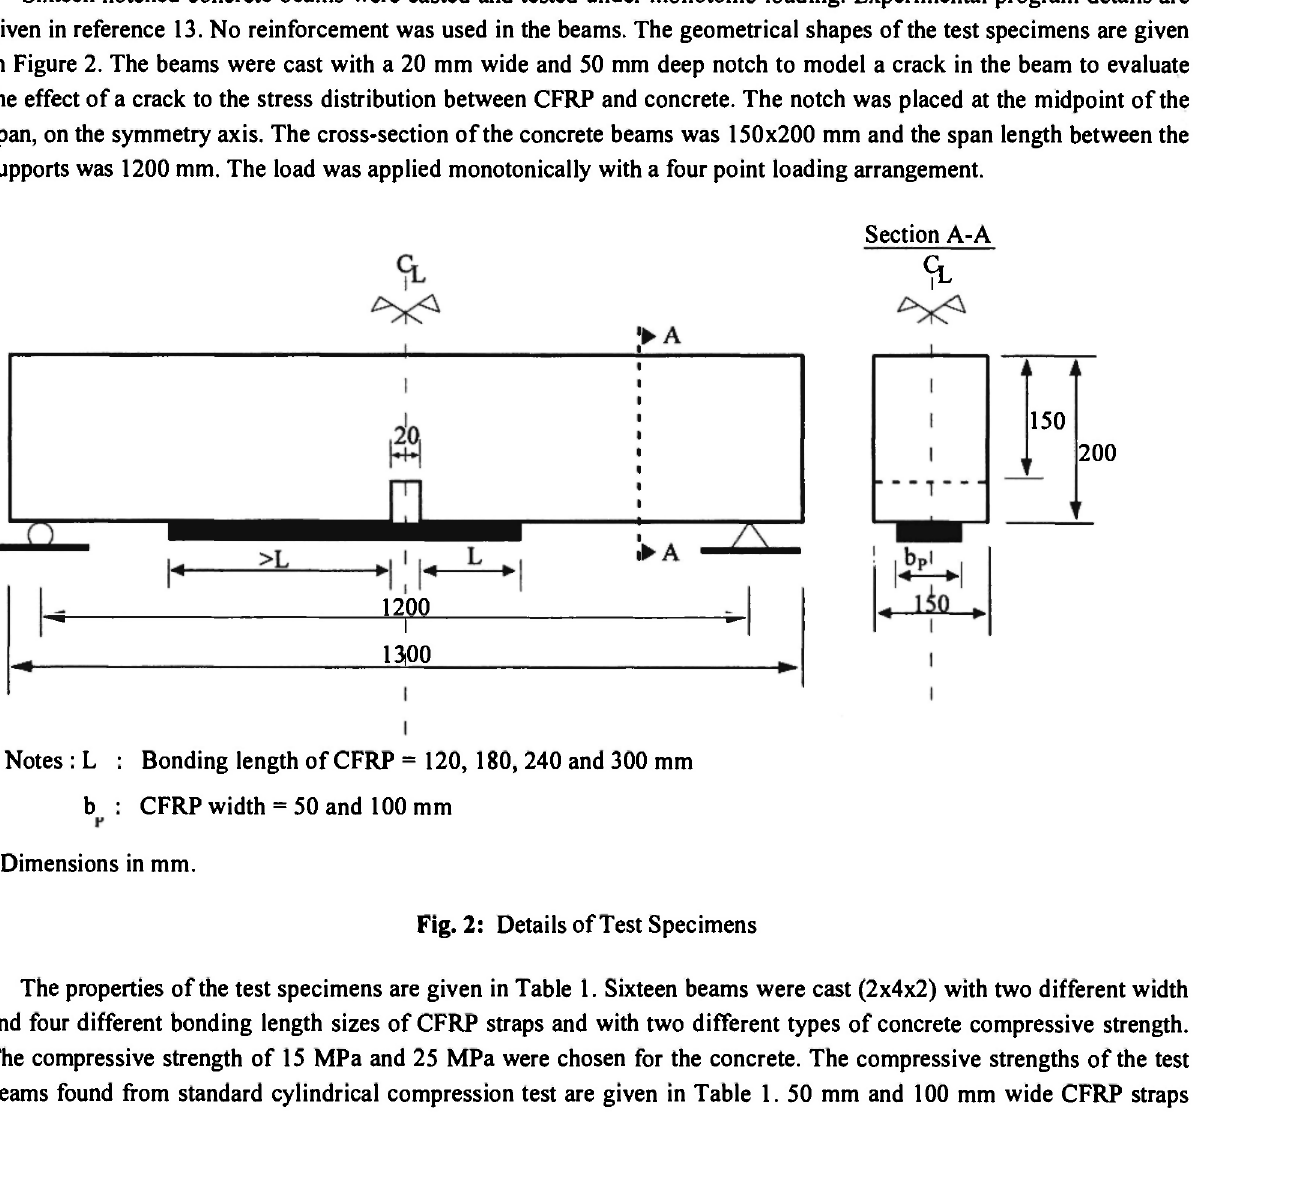
Fig. 2: Details of Test